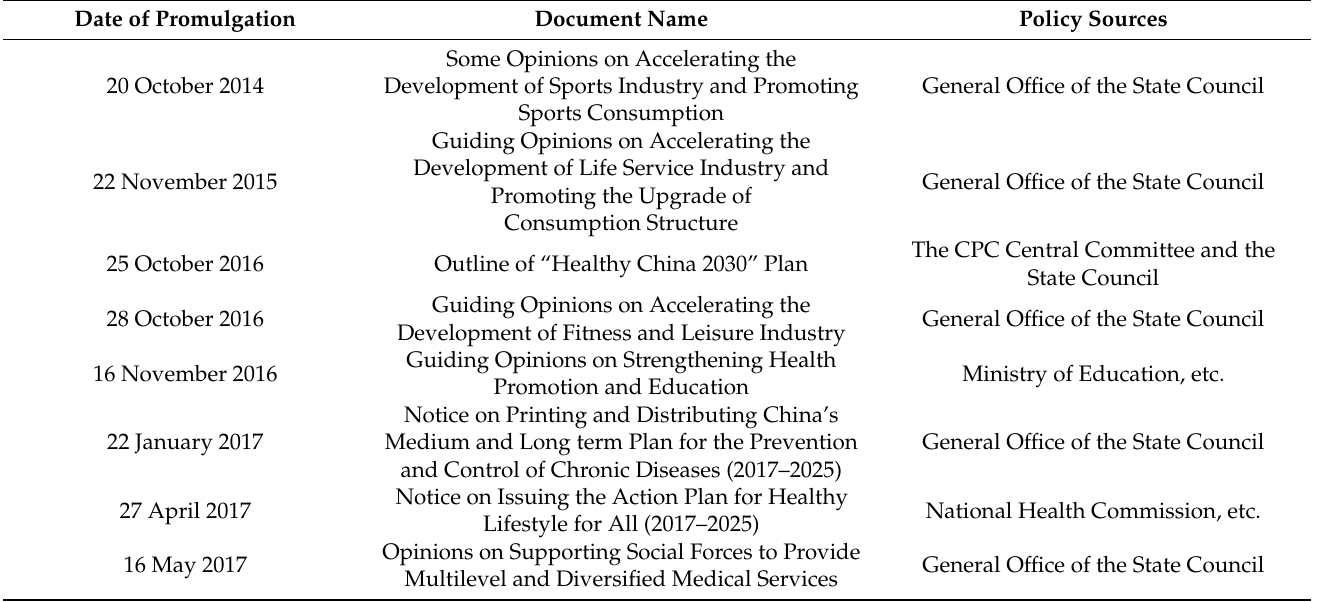
Table 1. Policies related to sports medicine integration at the national